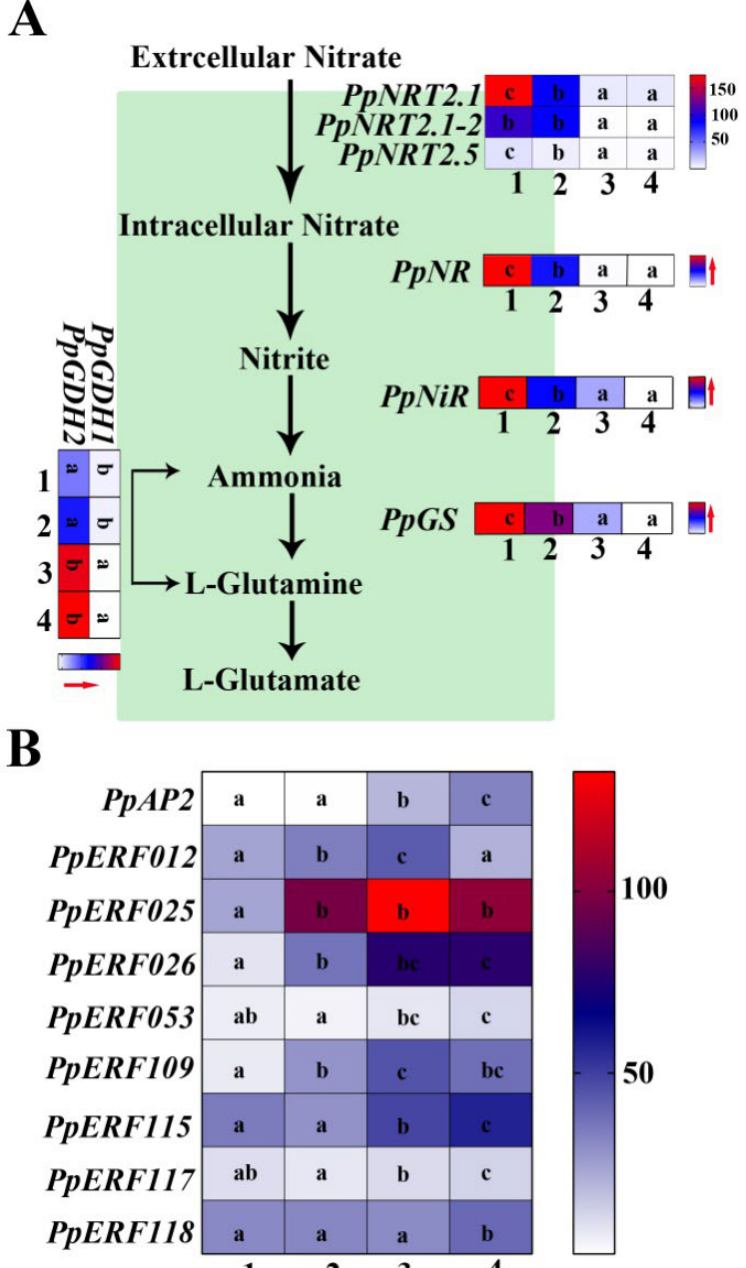
Figure 5. Nitrogen metabolic pathway in peach root. ( A ) Nitrogen metabolic pathway in peach root. The green background box represents the intracellular. PpNRT2.1 (LOC18773076), PpNRT2.1-2 (LOC18773670) and PpNRT2.5 (LOC18793381): genes encoding nitrate transporters; PpNR (LOC18790070): gene encoding nitrate reductase; PpNiR (LOC18767486): gene encoding ferredoxin-nitrite reductase; PpGS (LOC18790849): gene encoding glutamine synthetase; PpGDH1 (LOC18770115): gene encoding glutamate dehydrogenase 1 and PpGDH2 (LOC18785018): gene encoding glutamate dehydrogenase 2. 1, 2, 3 and 4 represents KNO 3 _S, KCL_S, KNO 3 _M and KCL_M. The red arrow represents the increase of FPKM value. ( B ) The normalized expression level (FPKM) of some differentially expressed ERF gene family members in the four cDNA libraries analyzed by heat map. Different lowercase letters indicate significant differences at p < 0.05 by one-way ANOVA with Duncan (D)’s multiple comparisons test.